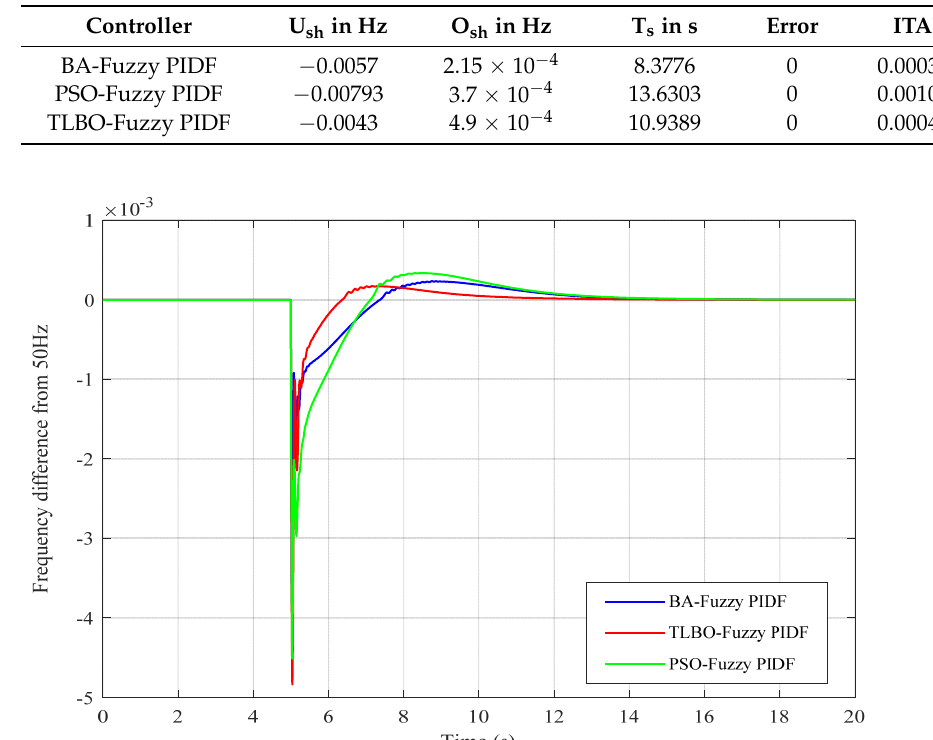
Table 13. Frequency response performance with Fuzzy PIDF controllers designed via ITAE.